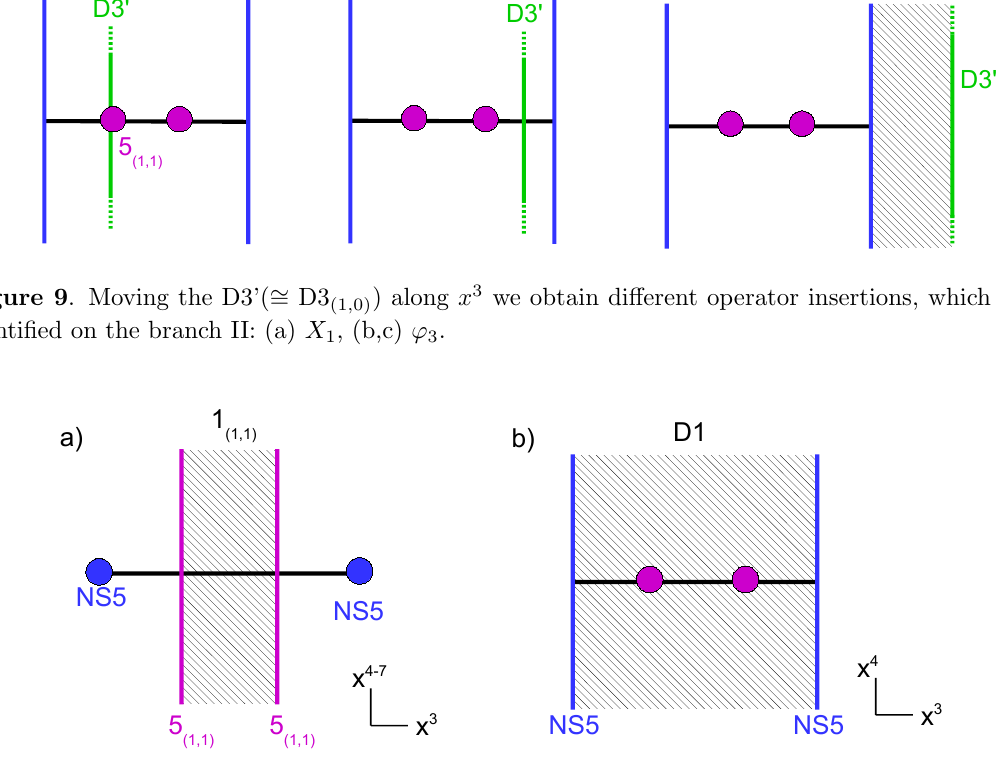
Figure 10 . Each of the two brane setups can be read in two ways, leading to the relations: (a) u + u (cid:0) = ( ’ 2 ) 2 , (b) v + v (cid:0) = X 2